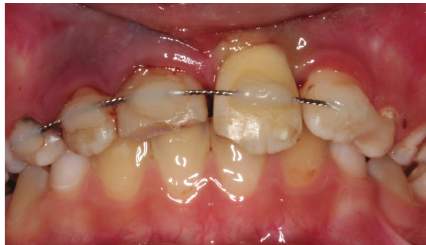
Figure 2: Splinting of the avulsed tooth with orthodontic wire and composite resin.